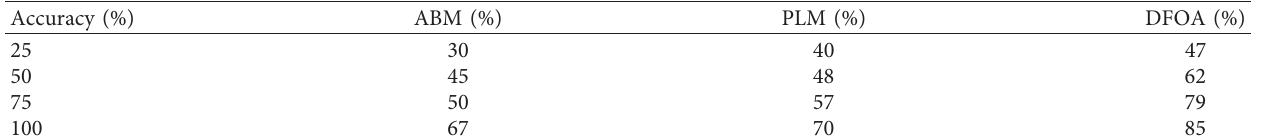
Table 2: The time complexity of the